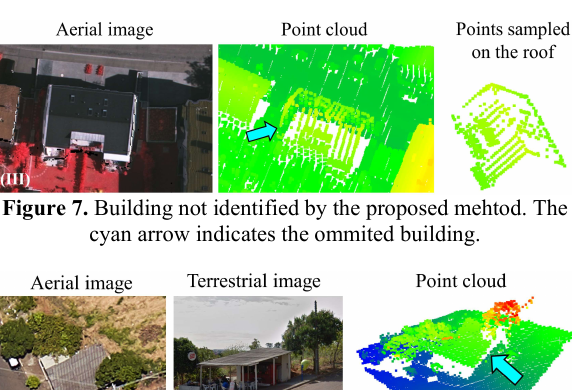
Figure 6. Objects incorrectly detected as building by the proposed method. Entrance to an underground parking lot (a) and canopy (b). The arrow in cyan indicates commission errors.